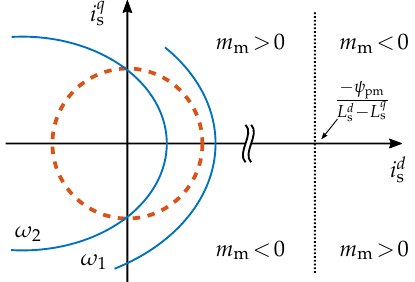
Figure 4. Illustration of the operation areas with the transient line ( ), the current limit ( ), and the voltage limit ( ) for two different speeds ω 1 < ω 2